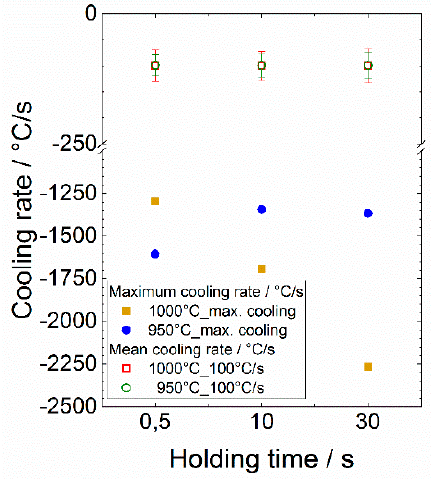
Figure 4. Actual cooling rates applied during the dilatometry for the experiments carried out at the maximum control temperatures of 950 and 1000 °C, respectively.